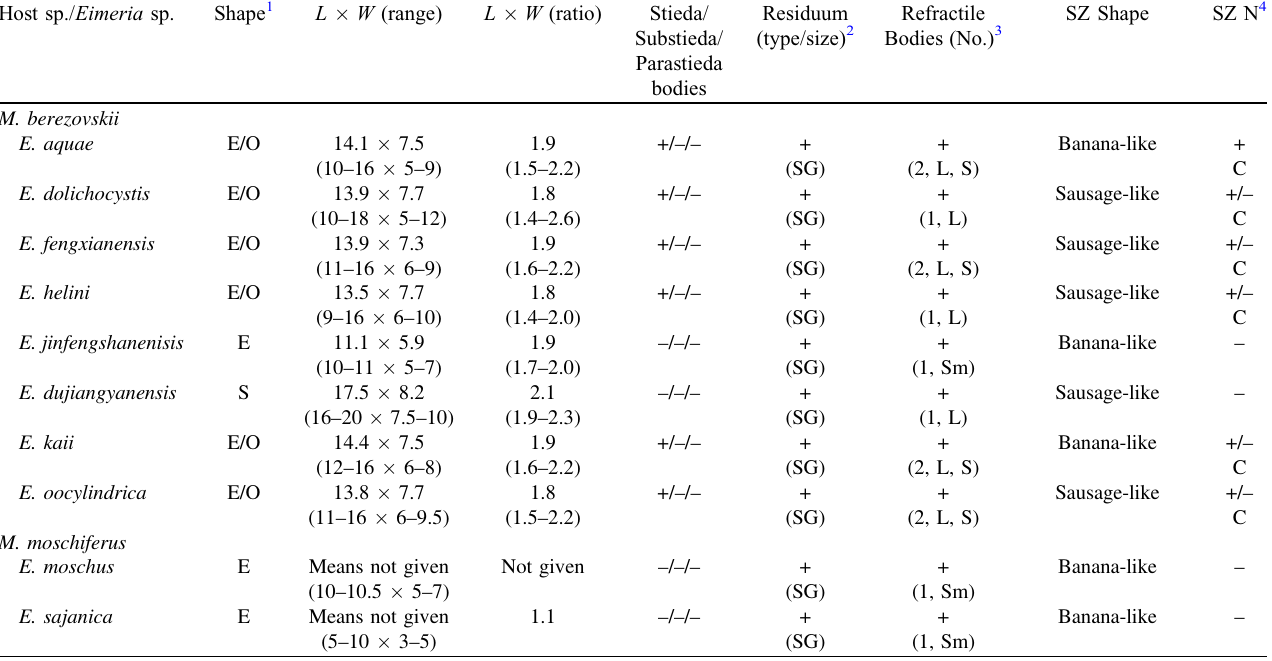
Table 2. De fi ning structural characters of the sporocysts/sporozoites of all Eimeria species known from all seven musk deer species (Moschidae: Moschus spp.) worldwide. Host sp./ Eimeria